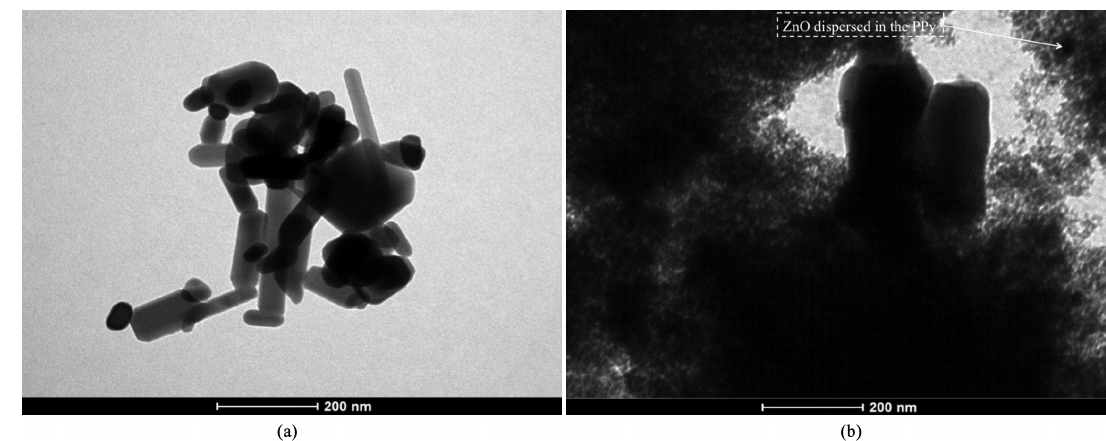
Figure 2. TEM image of: (a) ZnO_NPs and (b) ZnO_NPs/PPy